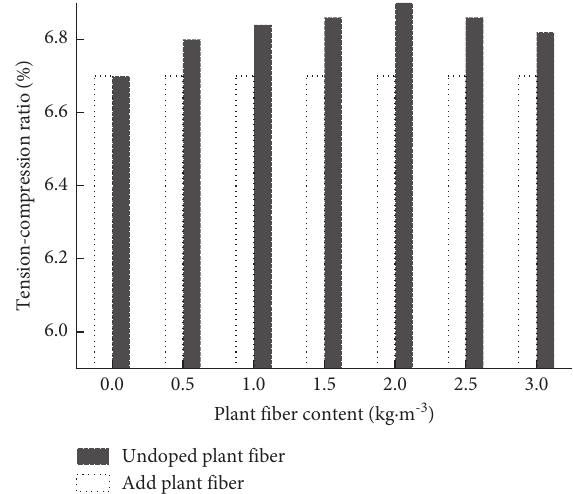
Figure 8: Comparison of tension-compression